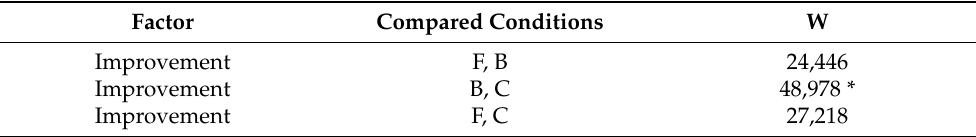
Table 11. Post-hoc Mann–Whitney tests results for improvement in Beginners. Factor Compared Conditions W Improvement F, B 24,446 Improvement B, C 48,978 * Improvement F, C 27,218